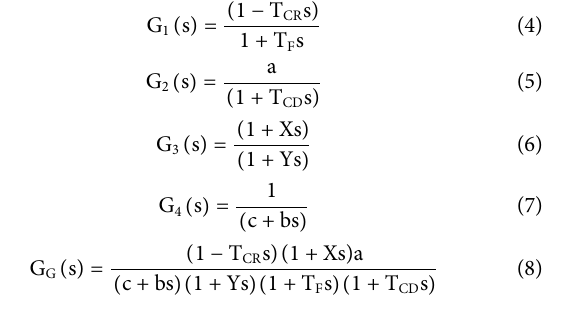
Frontiers in Energy